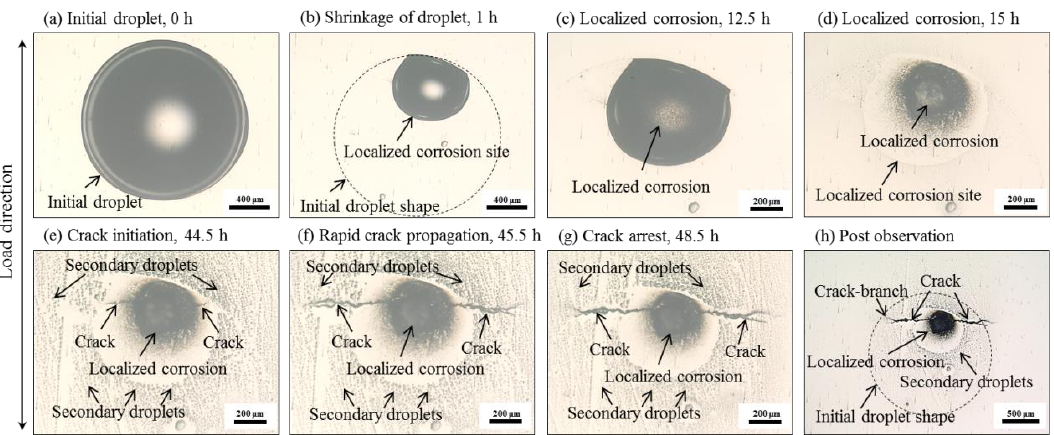
Figure 6. A single crack evolution in the u-bent specimen B exposed to a single droplet of 1 μL neutral 1% NaCl solution in 99% relative humidity at room temperature until the crack arrest in 48.5 h: (a–g) in-situ observation; (h) post-observation.